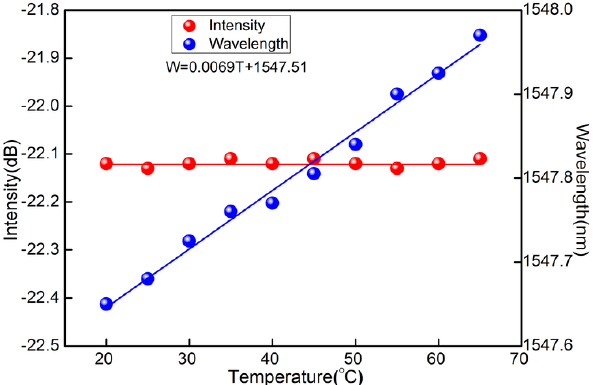
Figure 7. Temperature response performances of “cladding” FBG reflection resonance included wavelength and power fluctuation with increasing temperature.